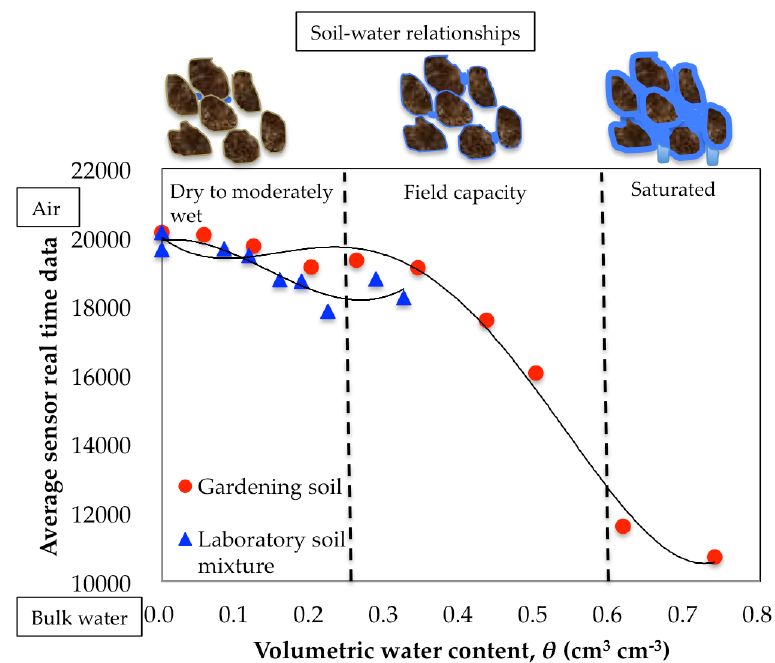
Figure 3. Average raw count as a function of the volumetric water content θ of the tested porous materials ( n = 20). The raw count varies with the dielectric constants of the bulk water and air and ranges between 10,000 and 20,000 according to the sensor